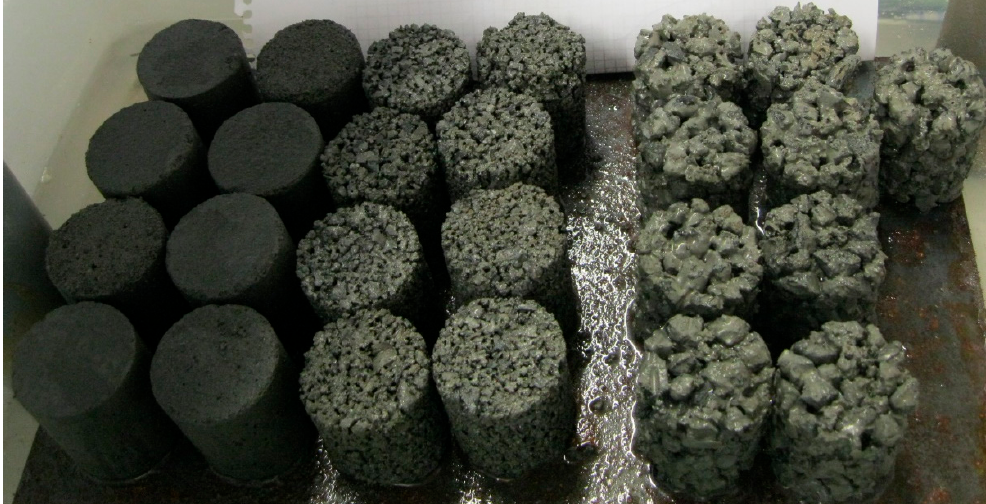
Figure 1. Specimens of the fine mixed slag (MS-F) ( left ), medium mixed slag (MS-M) ( center ) and coarse mixed slag (MS-C) ( right ) acoustic products.